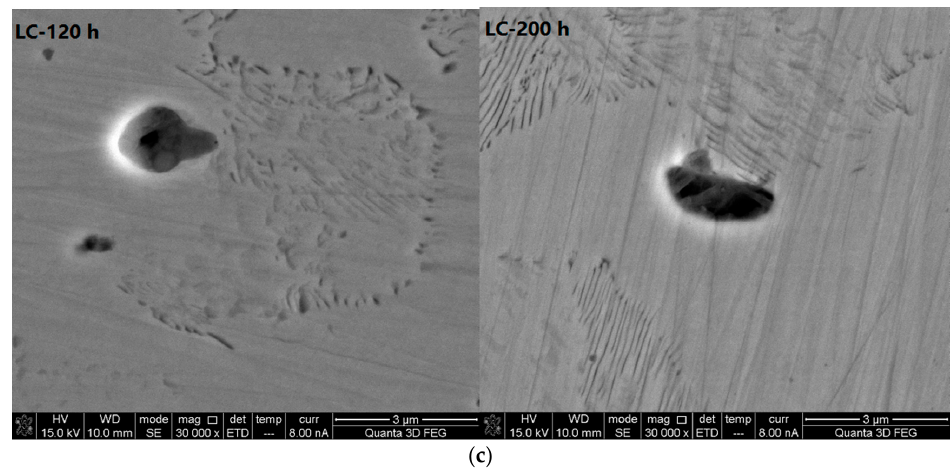
Figure 6. Scanning electron microscope photos (30,000× magnification) of carbon steel bars at different corrosive exposure times. ( a ) Micrograph of LC at 0 and 24 h; ( b ) Micrograph of LC at 60 and 100 h; and ( c ) Micrograph of LC at 120 and 200 h.